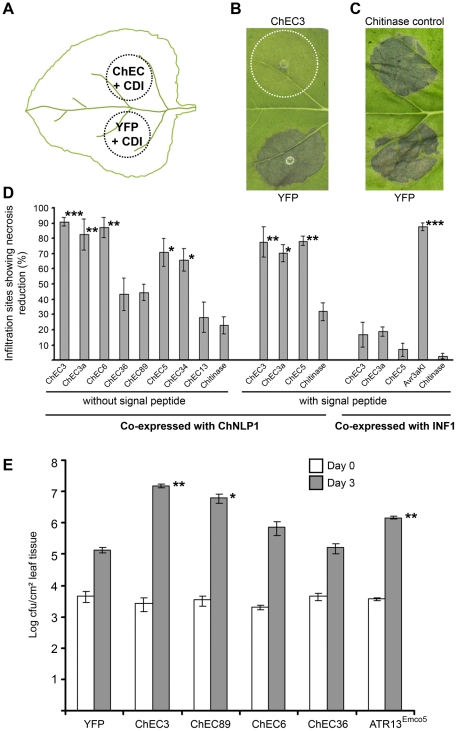
ChECs antagonizing plant cell death and supporting multiplication of plant pathogenic bacteria.(A) Infiltration scheme for the transient co-expression assay. Agrobacteria containing constructs for ChEC or YFP expression were mixed with those for cell death-inducer (CDI) expression. Mixtures were infiltrated into opposite sides of N. benthamiana leaves to allow pair-wise comparisons and to take account of leaf-to-leaf variation in necrosis manifestation. Thus, an infiltrated site expressing YFP/ChNLP1 was included as an internal control in every infiltrated leaf, to which the site expressing ChEC/ChNLP1 was compared. (B, C) Examples of infiltration site pairs 8 dpi. ChEC3 abolishes ChNLP1-induced necrosis (B, dotted circle), but a fungal secreted chitinase does not (C). (D) Quantification of cell death-suppressing activity of four wave 2 effectors (ChEC3, 3a, 6, 36), three wave 3 effectors (ChEC89, 34, 13) and an in vitro-expressed effector (ChEC5). Histograms show the proportion of sites expressing ChEC/CDI that displayed reduced necrosis compared to control sites expressing YFP/CDI. *, ** and *** indicate significant difference from the respective chitinase control with and without signal peptide at P<0,02, <0.005 and <0.0002, respectively (Student's t-test). P. infestans effector Avr3aKI was used as positive control for suppression of INF1-induced cell death. Data represent means of at least three independent experiments, with at least 15 leaves/experiment/co-expression combination (± standard error). (E) Bacterial titers in Arabidopsis Col-0 leaves infected with Pseudomonas syringae pv tomato expressing ChECs as fusions with a bacterial effector mediating delivery into plant cells via type III secretion. Hyaloperonospora arabidopsidis ATR13Emco5
[27] and YFP were included as positive and negative controls, respectively. Colony forming units were determined 0 and 3 days after spray inoculation. * and ** indicate significant difference from the YFP control at P<0.03 and P<0.0005, respectively. Data represent means of 4 replicates (± standard error).